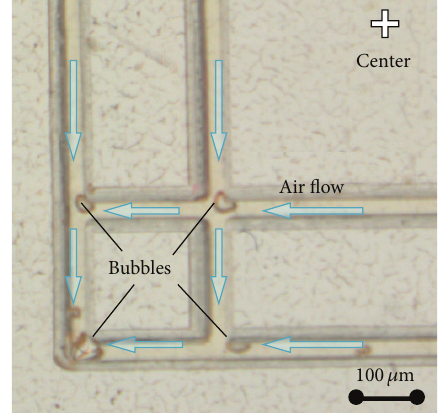
Figure 14: Bubbles’ formation.